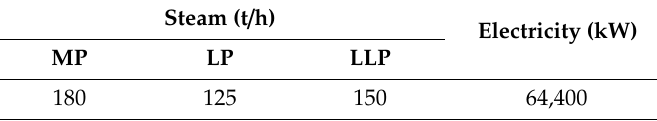
Table 8. Single-period steam and electricity